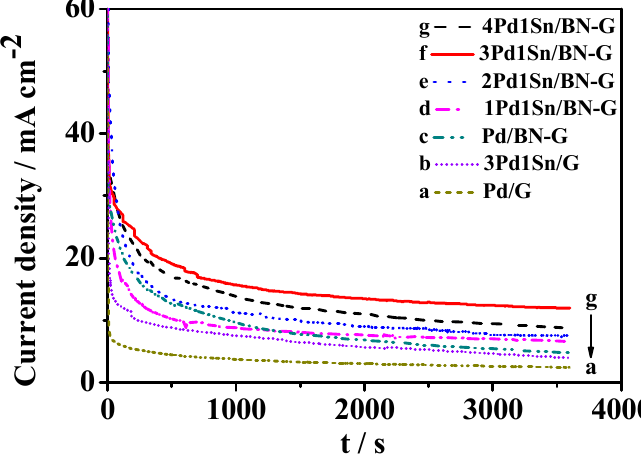
Figure 5. Chronoamperometric curves of all the catalysts in the solution with 1 M HCOOH + 0.5 M H 2 SO 4 solution at 0.4 V.